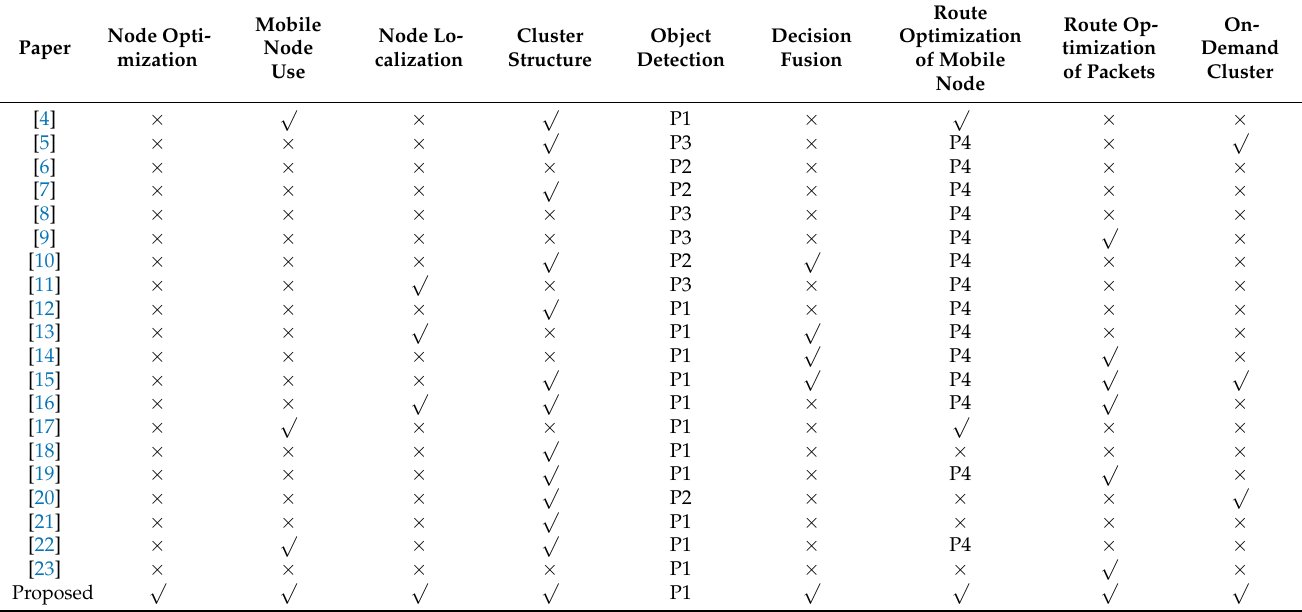
Table 1. Features incorporated in different models and in our